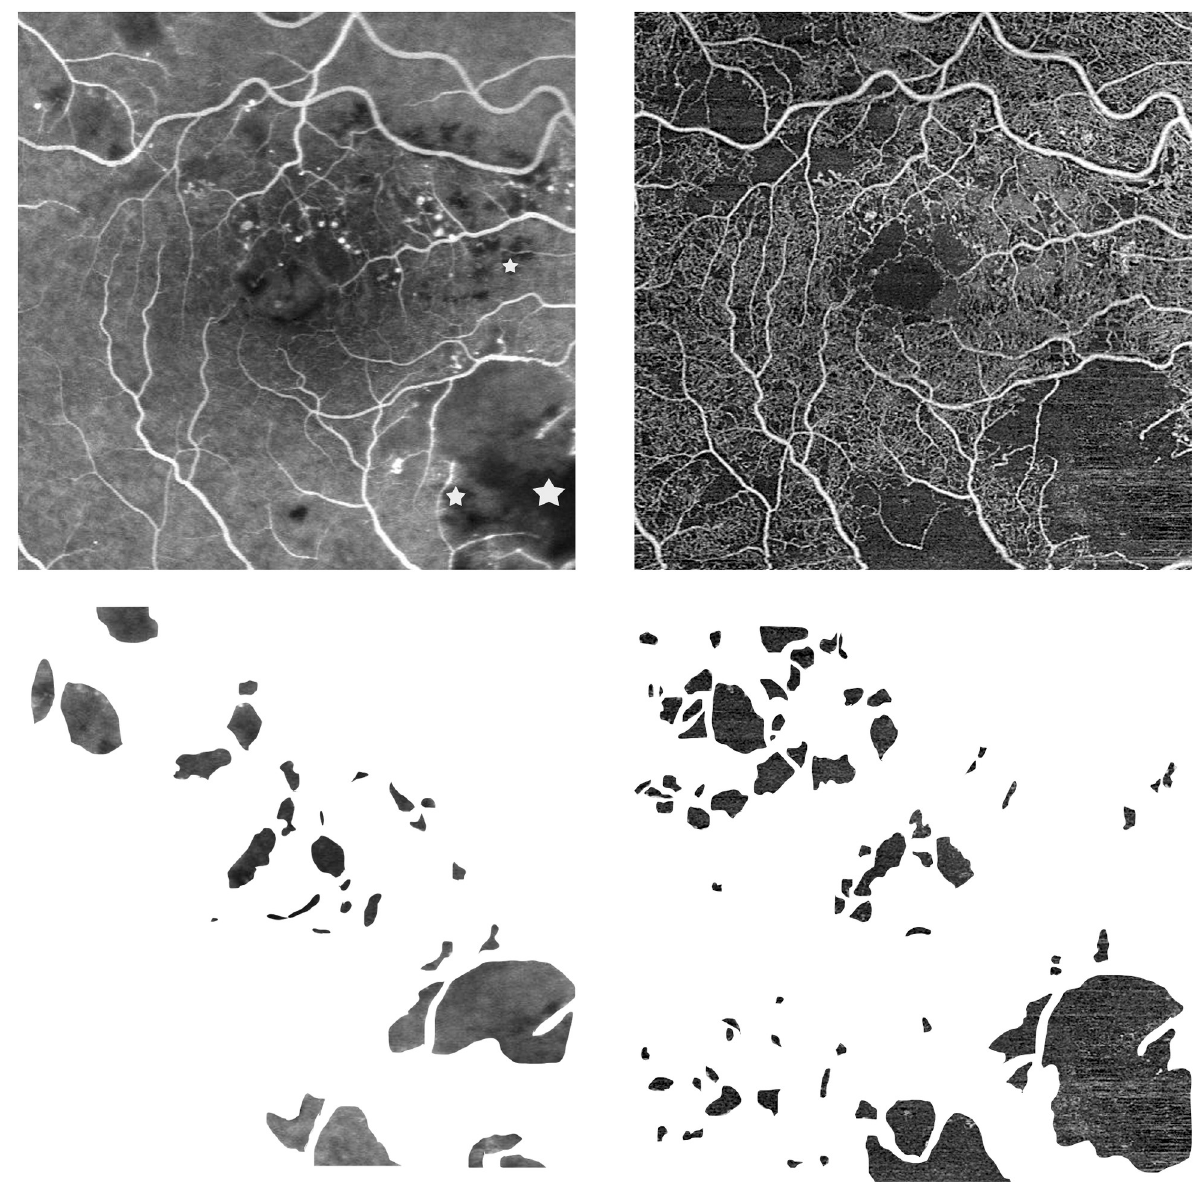
Fig 1. Example of areas of non-perfusion as determined by angiography fluorescein (FA) and Swept-Source Optical Coherence Tomography Angiography (SS-OCTA) images. Upper left: early phase FA image. Upper right: OCTA image of the retina slab. Lower left: Extracted annotated areas of non-perfusion from the FA image. Marked with white stars are areas which couldn’t be evaluated due to cotton wool spots and hyperreflective material. Lower right: Extracted annotated areas of non-perfusion from the OCTA